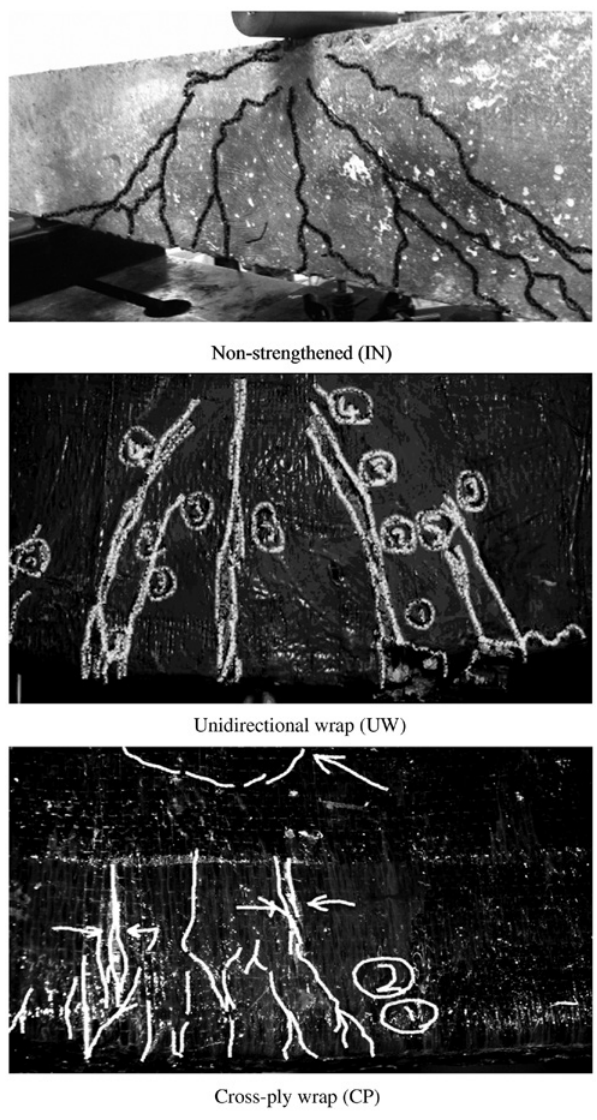
Figure 5: Failure modes of nonstrengthened and strengthened RC beams.